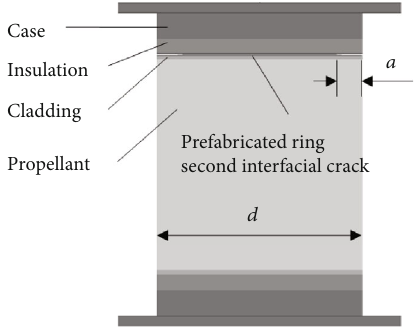
Figure 3: The design of insulation/cladding interface debonded crack specimen.